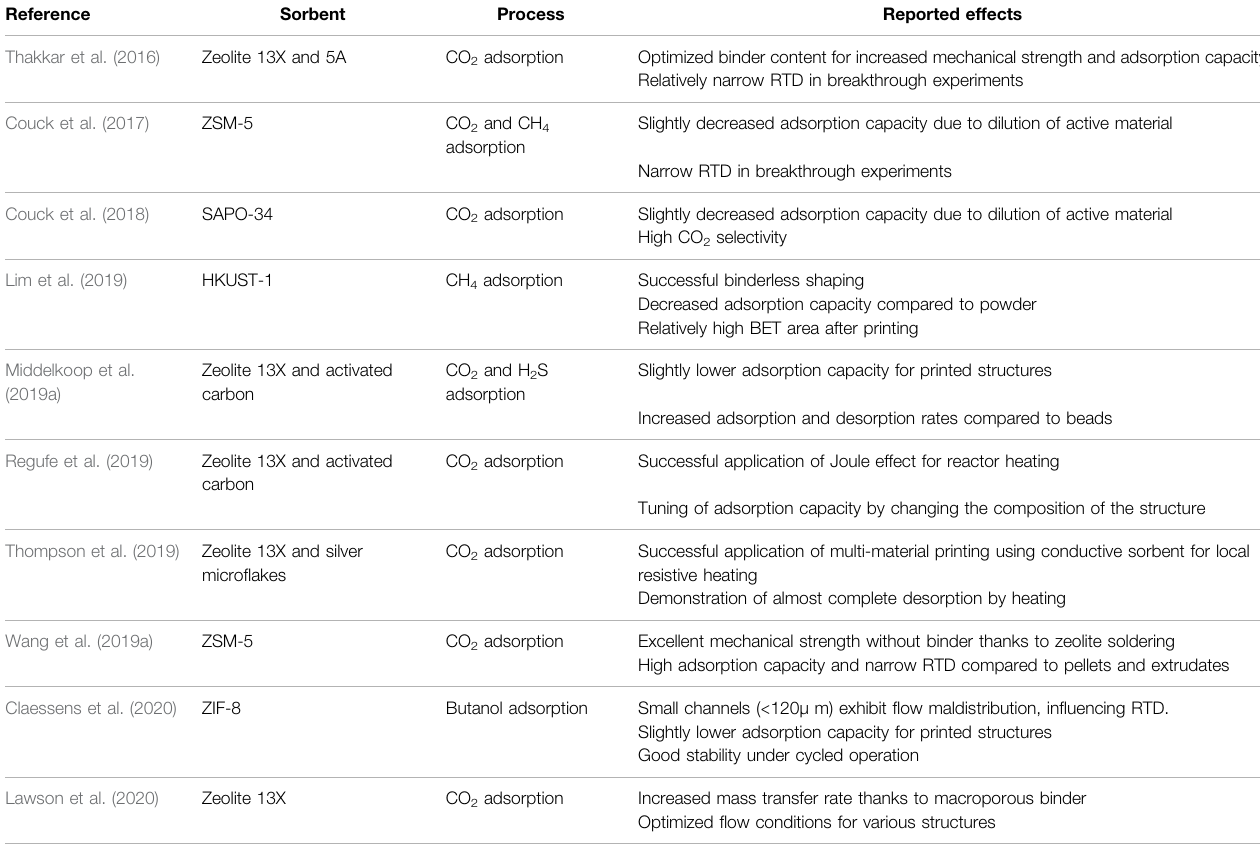
TABLE 2 | Overview of recent literature studies using sorbent logpile structures produced by DIW.